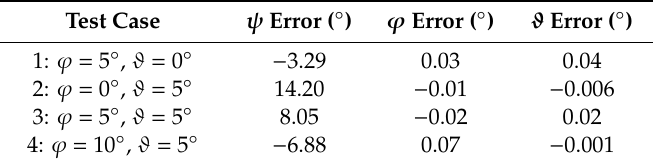
Figure 9. Schematic workflow for the attitude estimation from multiple limb images of an ellipsoid. Table 4. Error angles retrieved during experimental tests.